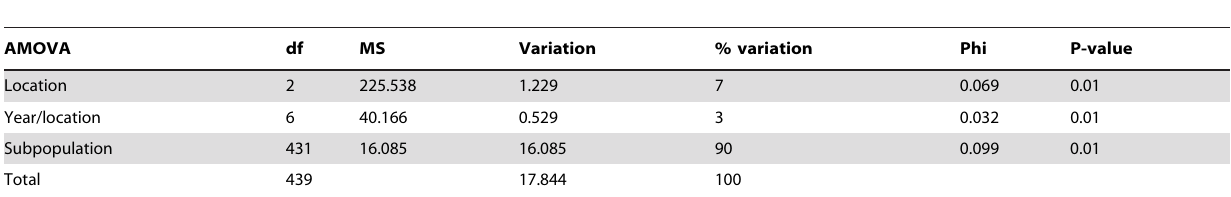
Table 5. Nested analysis of molecular variance (AMOVA) based on 129 polymorphic loci based on populations sampled at three locations (BADGER, RNA, and KEYSTONE), for three different years (1995, 2004, 2009).